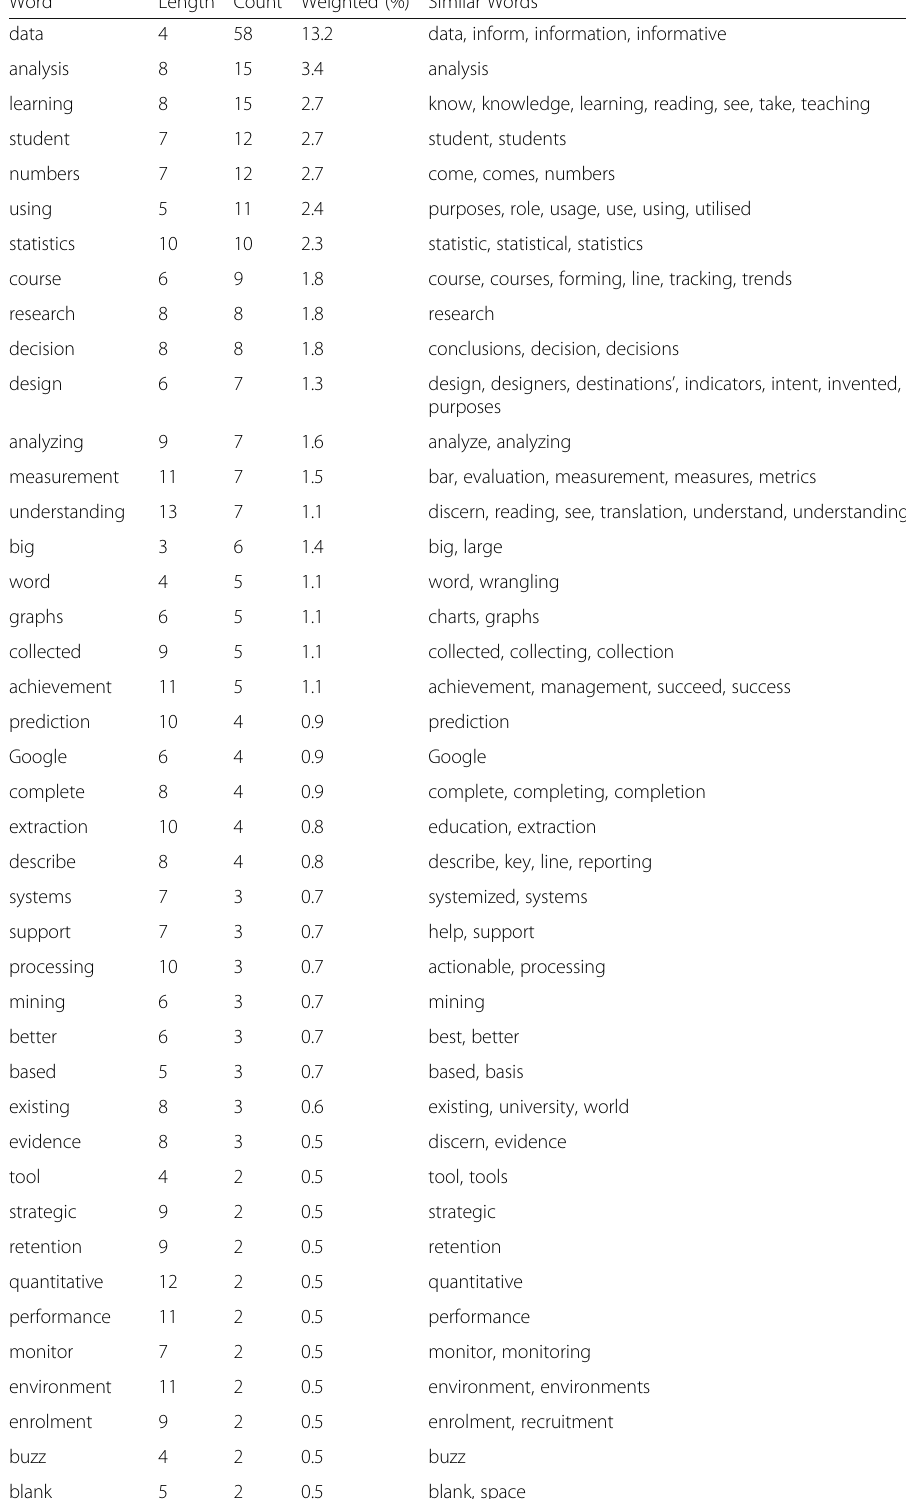
Table 2 Perceptions of analytics, basic list of terms and their frequencies